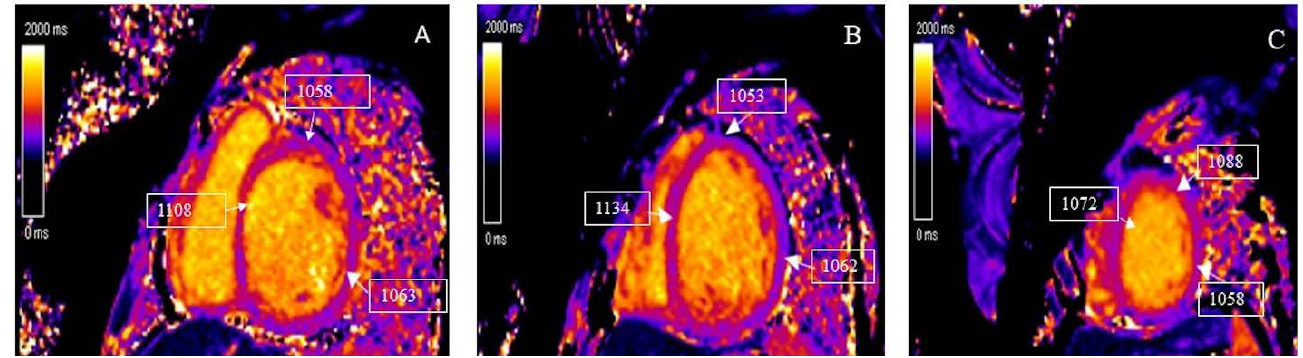
Figure 5. T1 mapping demonstrating the global increase in myocardial T1 relaxation times at the base ( A ), mid-ventricular level ( B ), and the apex ( C ). The average left ventricular myocardial T1 relaxation time is mildly prolonged (1077 ms).